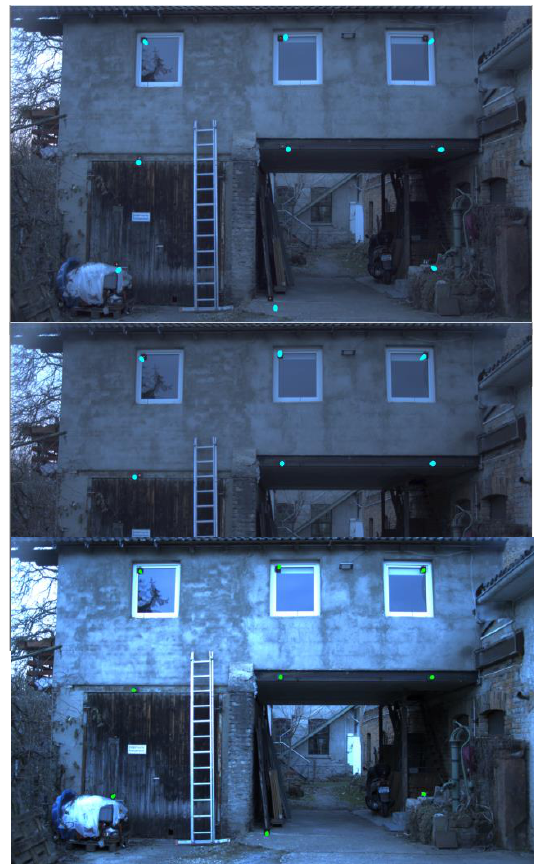
Figure 9. Comparing different overlay transformations, from top to bottom: Without calibration, with affine transformation & with perspective transformation